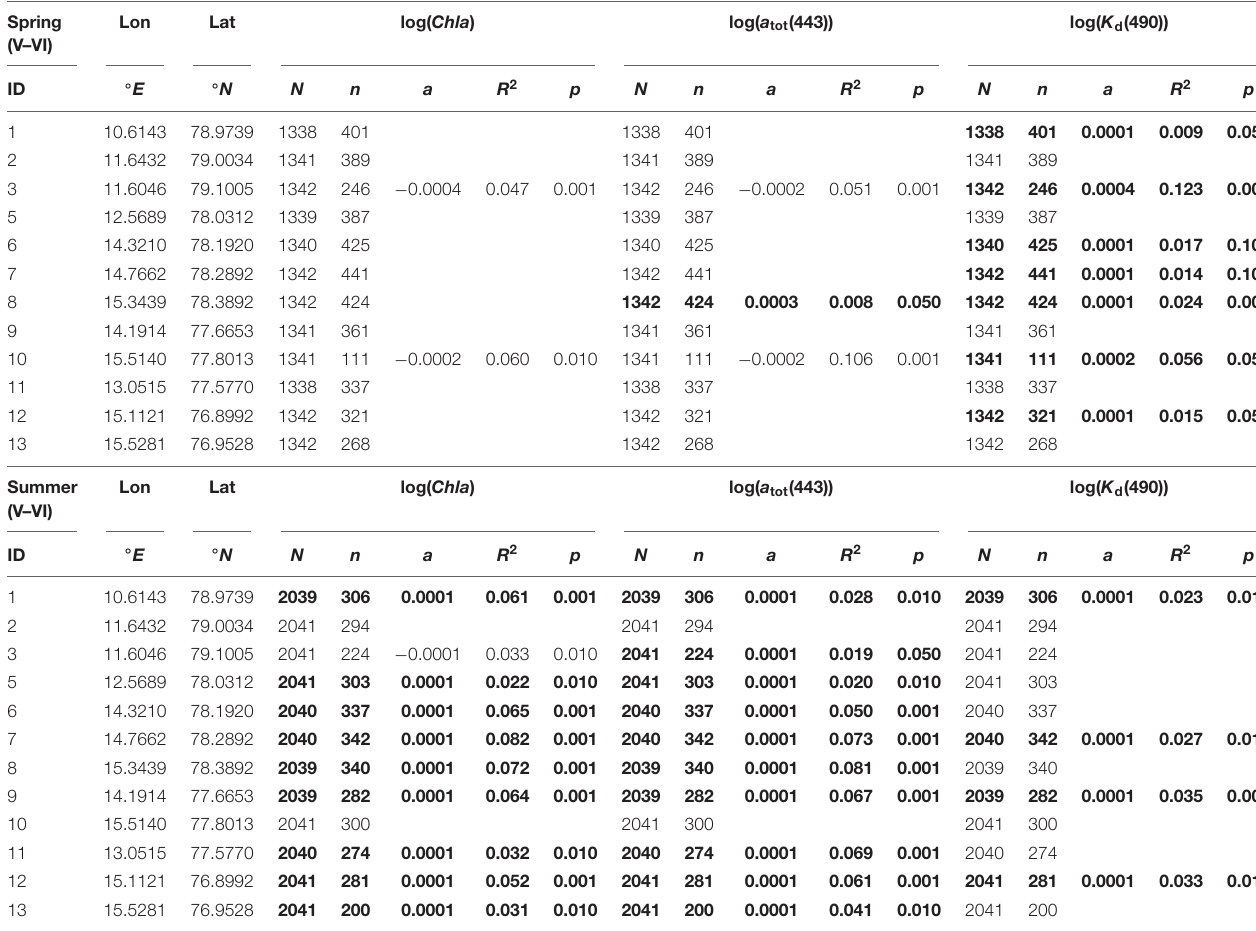
TABLE 1 | Identified trends based on the changes of the Chla [mg m − 3 ], K d (490) [m − 1 ], and a tot (443) [m − 1 ] during spring (V–VI) and summer months (VII – IX) in the years 1997 – 2019. Spring